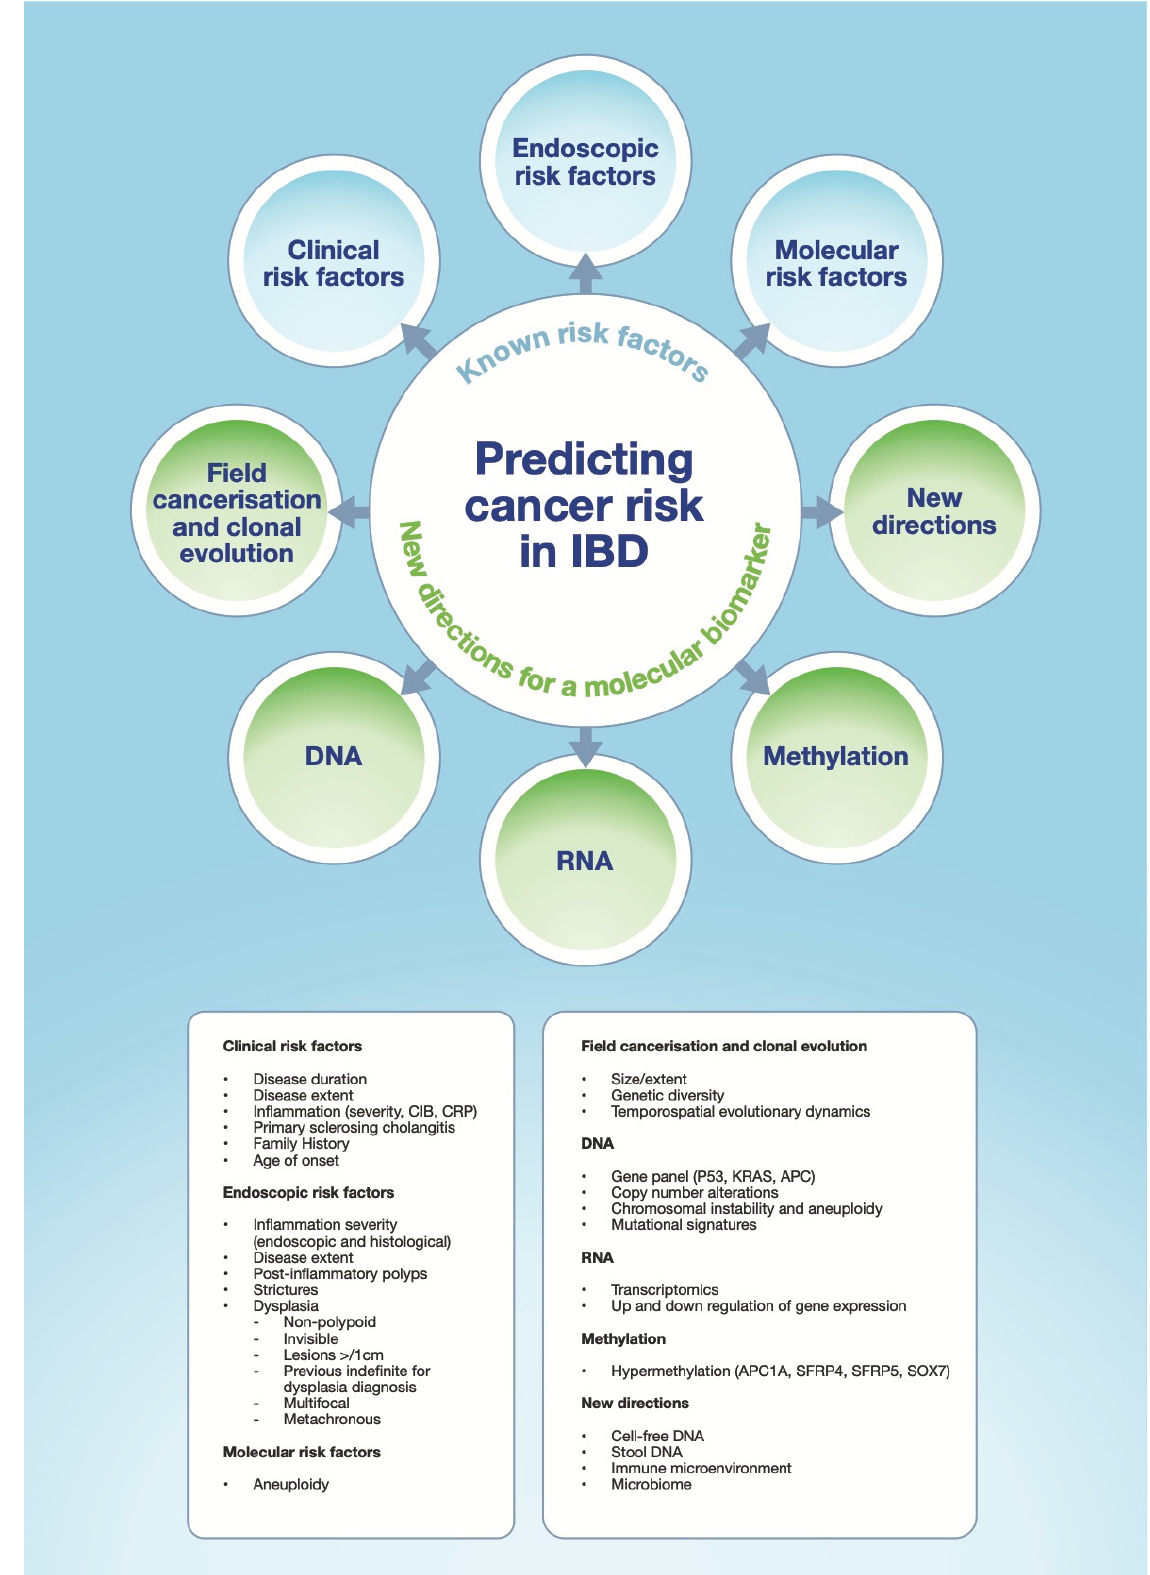
Figure 1. Demonstrates the known risk factors for predicting cancer risk in patients with IBD, and illustrates the potential novel directions for a molecular biomarker for disease progression. CIB—cumulative inflammatory burden, CRP—C-reactive protein.